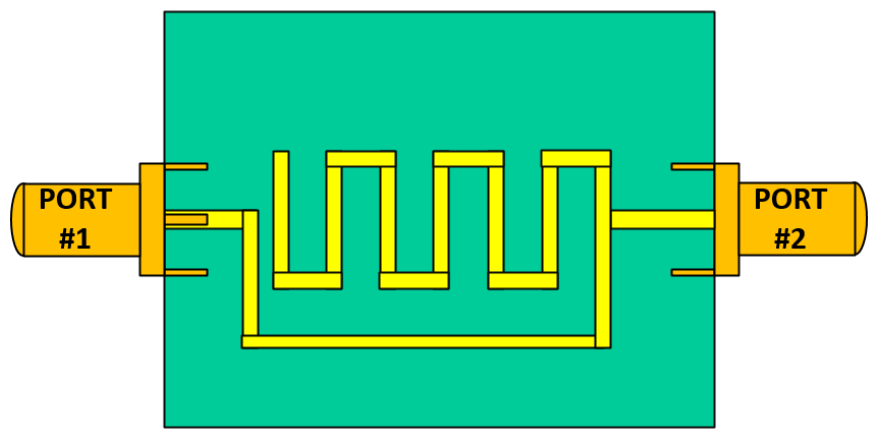
Figure 26. Photograph of the flexible gas sensor on Kapton substrate.